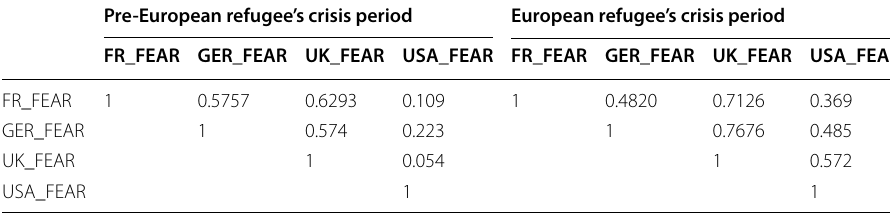
Table 5 Correlation matrix pre and European refugee’s crisis period